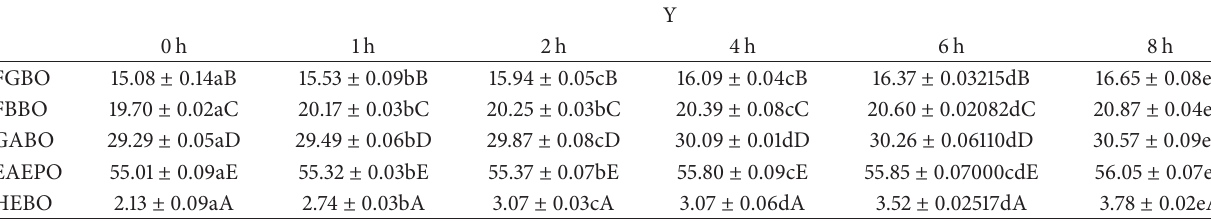
Table 1: Variation of yellow color of blended oils.